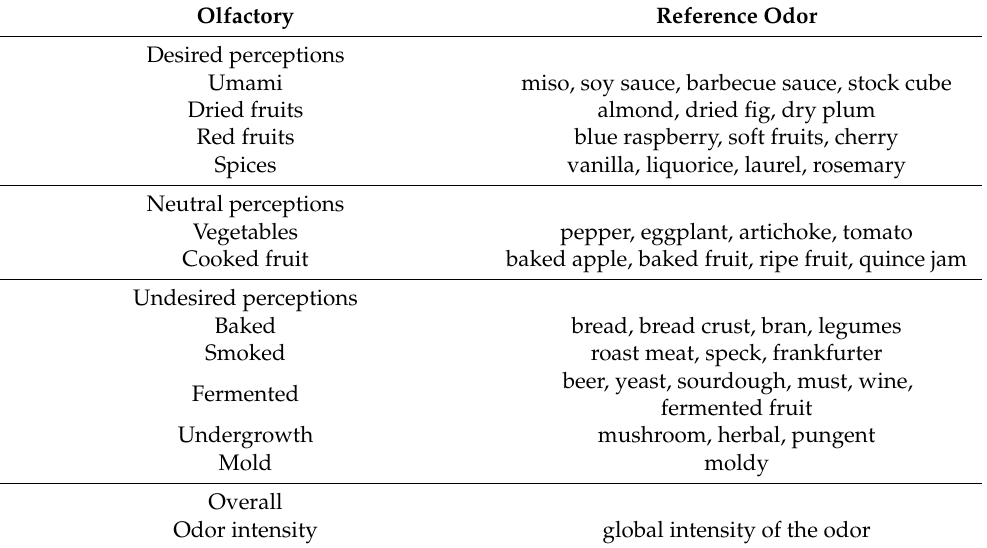
Table 7. Odor descriptors selected for fermented jellyfish paste